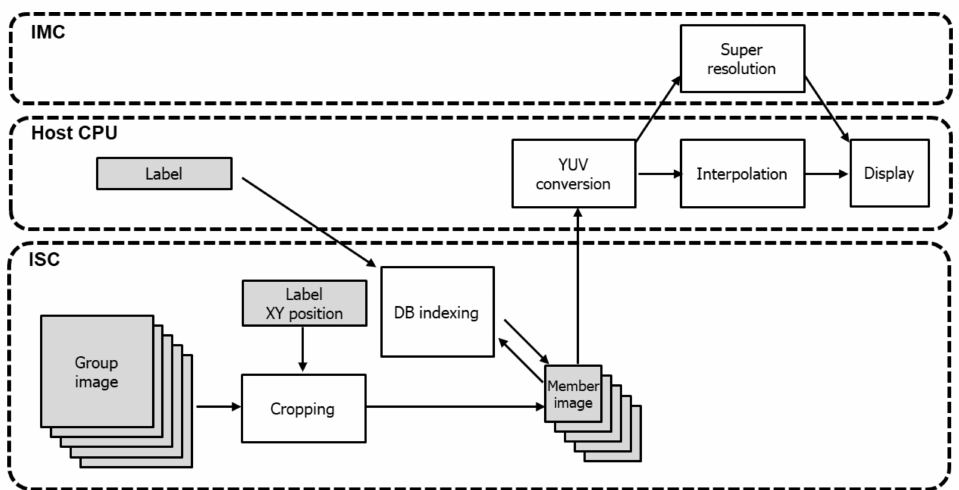
Figure 5. Mapping of tasks and devices for the focus